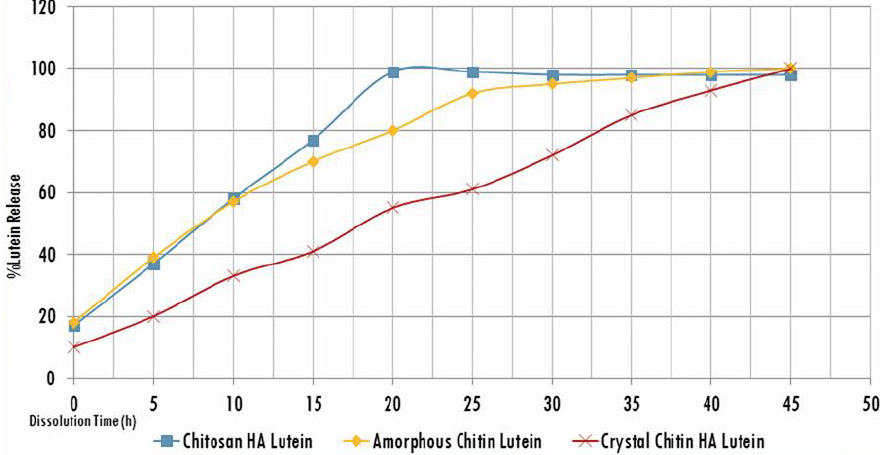
Figure 5. Release profile for lutein from chitin/chitosan